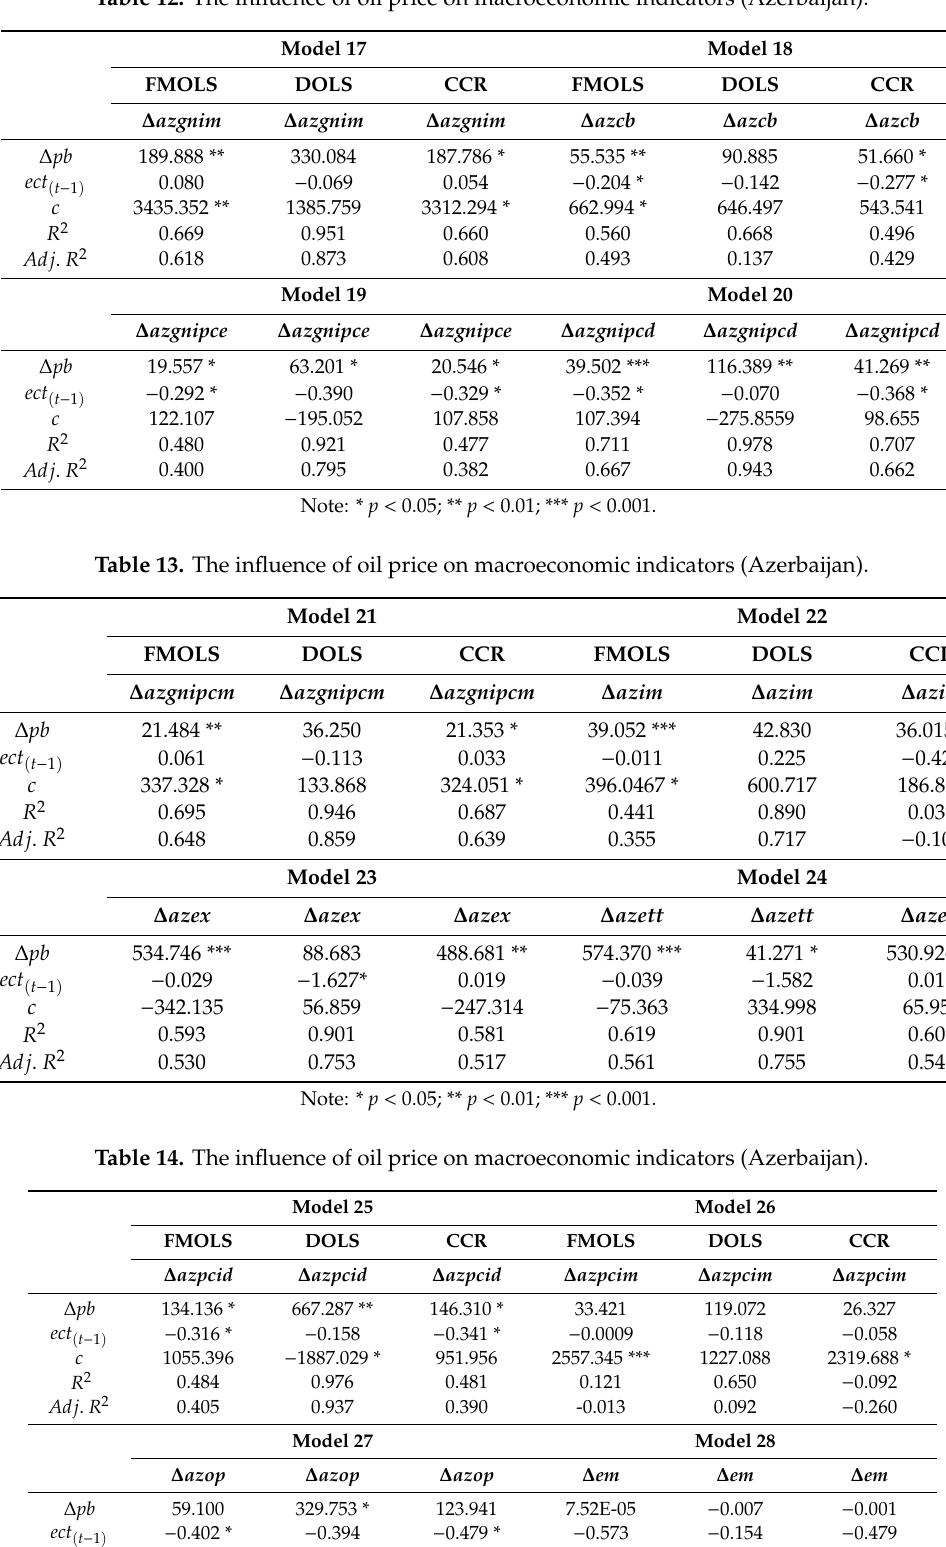
Table 12. The influence of oil price on macroeconomic indicators (Azerbaijan).